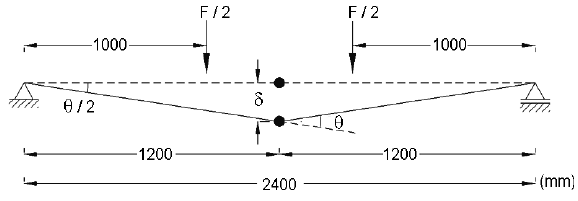
Fig. 6. Global plastic mechanism and plastic rotation